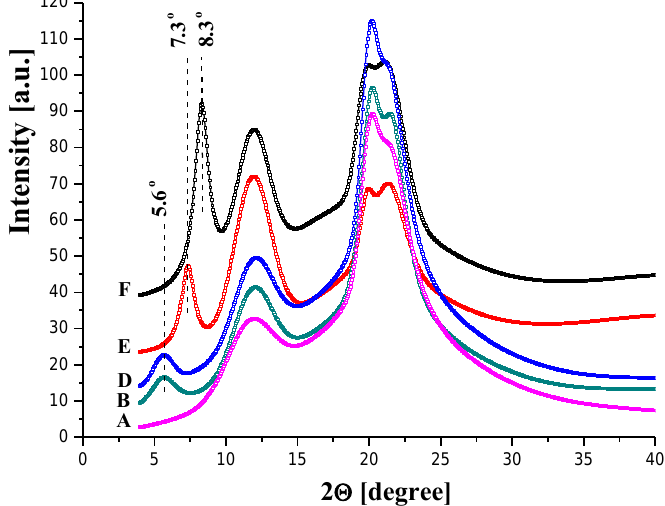
Figure 18. Examples of WAXS patterns of cellulose membranes (the letters on the left indicate the membrane codes).